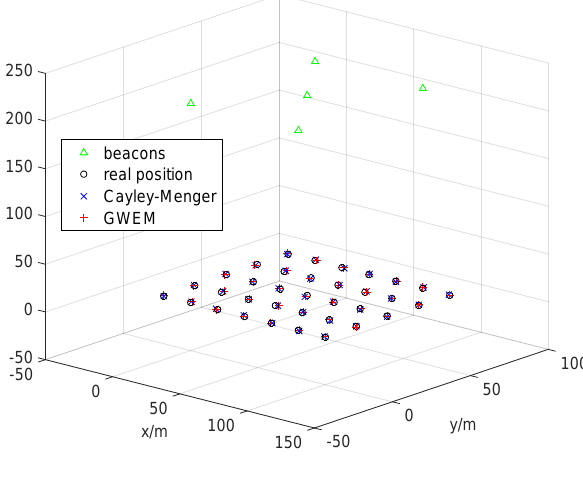
Figure 14. The experiment results.